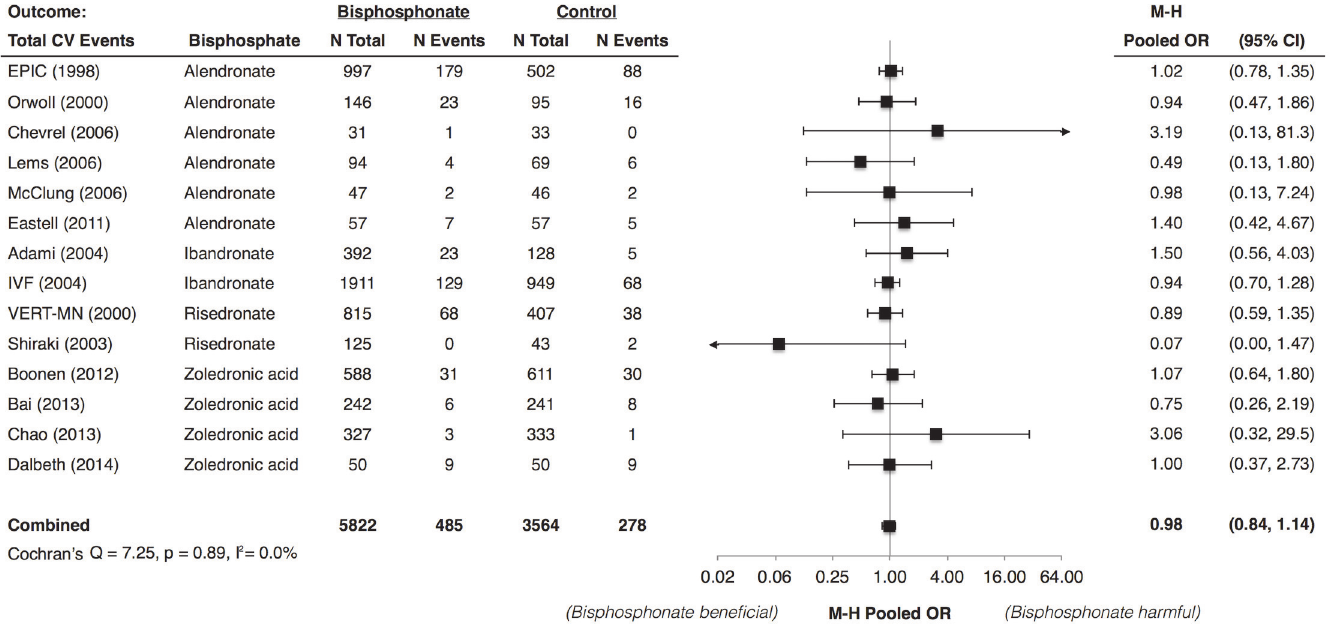
Fig 2. Meta-Analysis of Total Adverse Cardiovascular Events Associated with Use of Bisphosphonates. Abbreviations: CI, confidence interval; CV, cardiovascular; EPIC, Early Postmenopausal Intervention Cohort study; IVF, IntraVenous Fracture study; M-H, Mantel Haenszel; OR, odds ratio; VERT-MN, Vertebral Efficacy with Risedronate Therapy Multinational